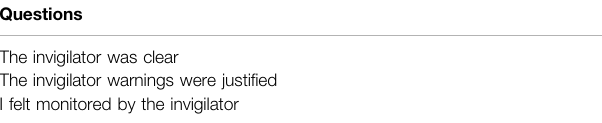
TABLE 3 | List of questions for quality of invigilation — study two. Questions